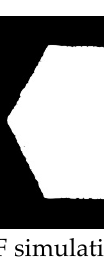
Figure 12. CA and PF simulate hexagonal snow patterns.